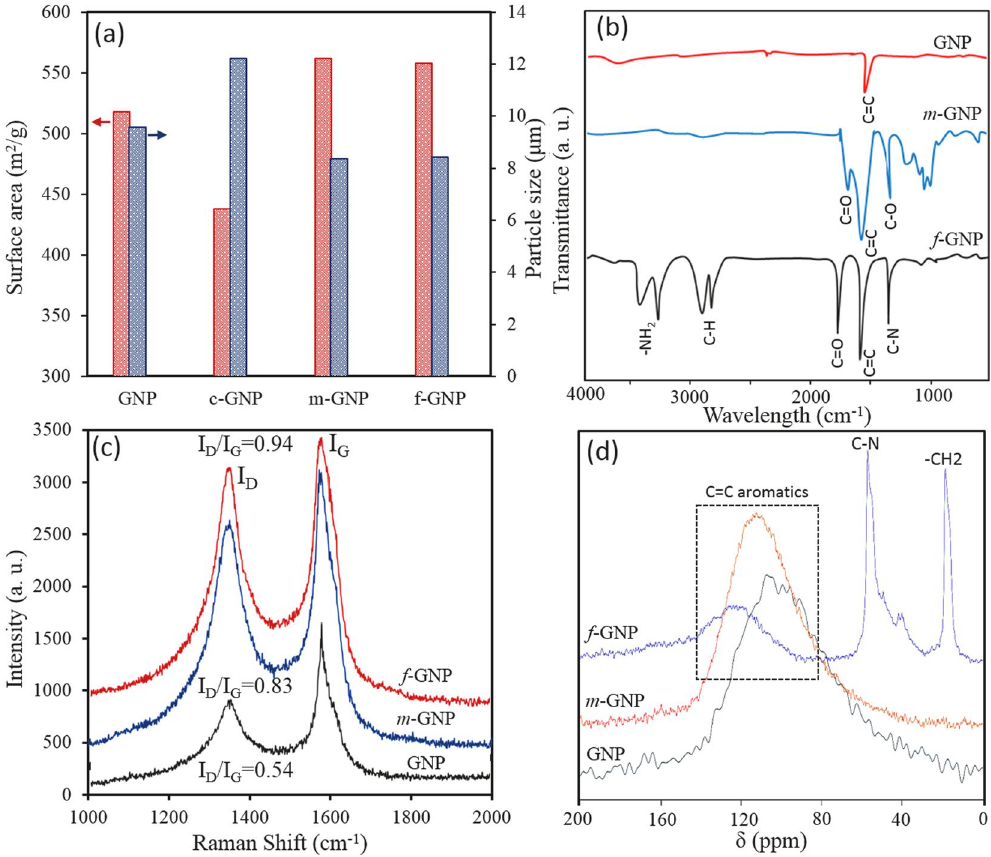
Figure 3. Surface area and particle size results ( a ), FTIR spectra ( b ), Raman spectra ( c ), and C 13 NMR spectra ( d ) of GNP, m -GNP and f